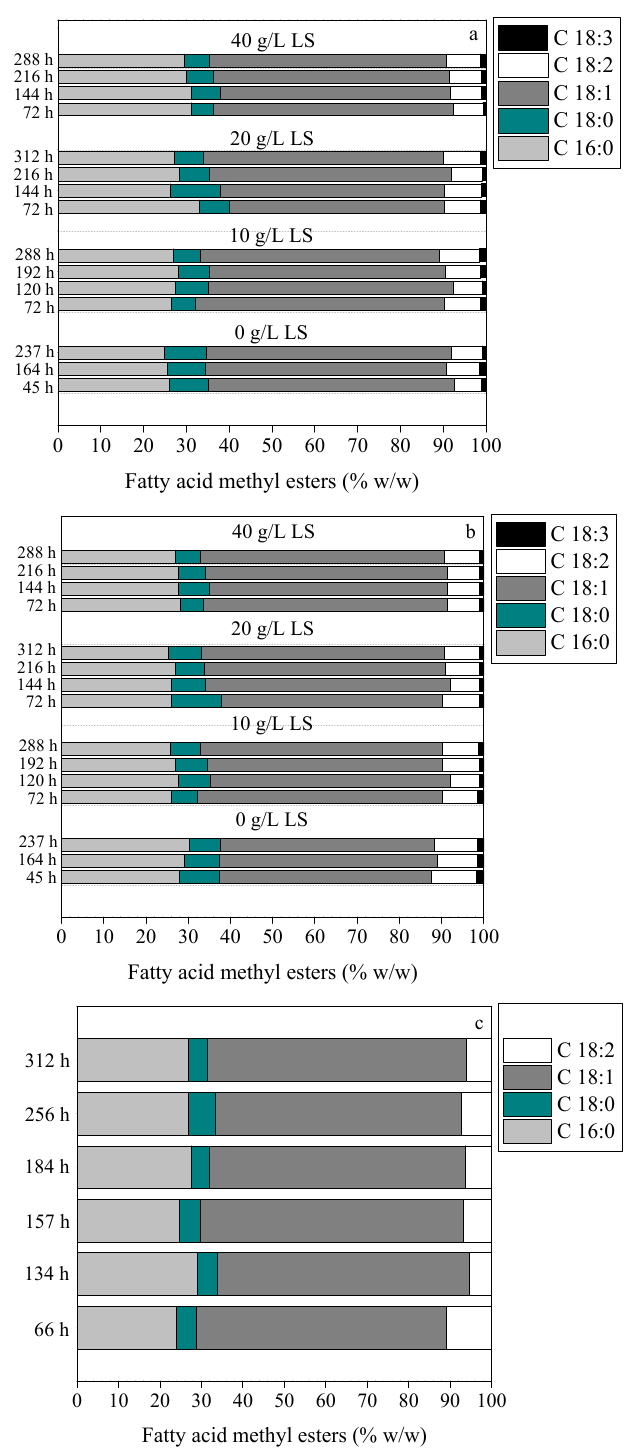
Figure 4. Fatty acid profile of microbial oil that was derived from experiments that were carried out with R. toruloides yeast strains that were cultivated on xylose-based media containing various concentrations of lignosulphonates (LS). ( a ) Batch fermentation with R. toruloides DSM 4444, ( b ) batch fermentation with R. toruloides Y 27012, and ( c ) fed-batch fermentation with R. toruloides Y 27012. Overall, in this study, novel wild-type and non-conventional yeast strains were screened under nitrogen-limited conditions on xylose-based media, demonstrating inter-